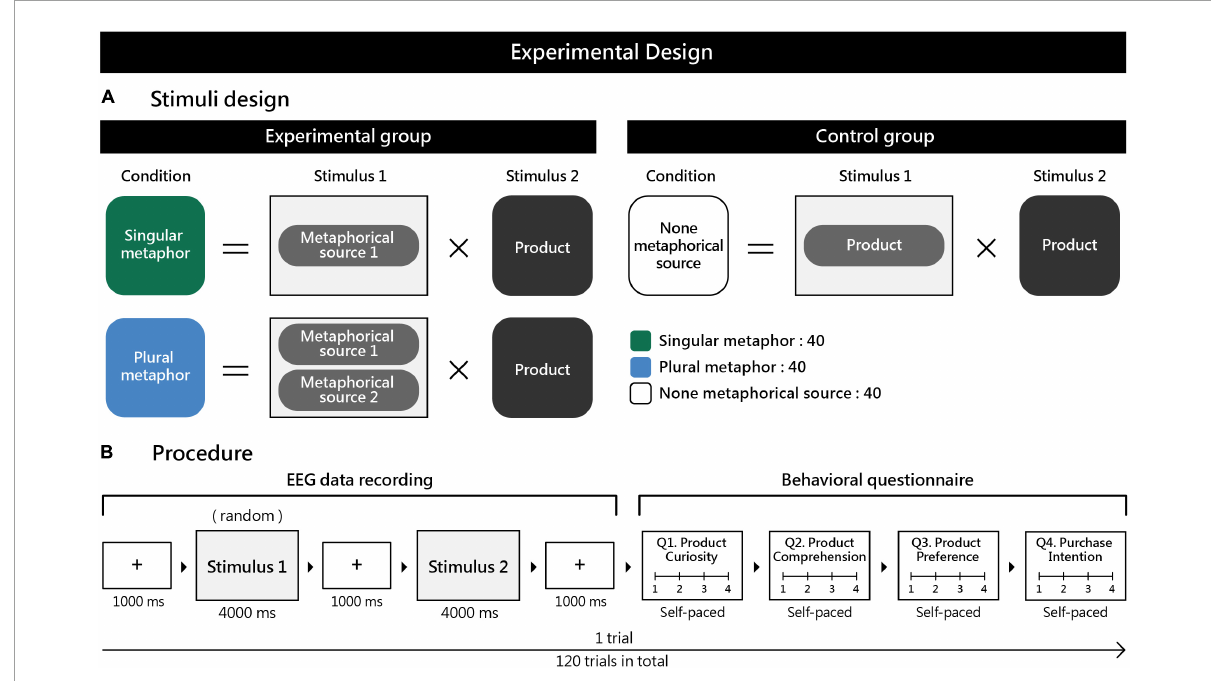
FIGURE1 (A) Each experimental condition consisted of stimuli 1 and 2. The three conditions are described as follows: The singular metaphorical source condition involved presenting a surreal marketing image with one metaphorical source (stimulus 1) + an actual product image (stimulus 2), for a total of 40 trials. The plural metaphorical sources condition involved presenting a surreal marketing image with two metaphorical sources (stimulus 1) + an actual product image (stimulus 2) for a total of 40 trials. The no metaphorical source condition involved presenting actual product images for both stimuli 1 and 2 for a total of 40 trials. (B) One trial in the experimental procedure consisted of EEG data recording and the administration of a behavioral questionnaire. EEG data recording: A fixation cross was first presented for 1000 ms, followed by the randomized presentation of marketing images (stimulus 1) for 4000 ms. The fixation cross was presented again for 1000 ms, and then the product image (stimulus 2) was presented for 4000 ms. At the end of the EEG data recording, the behavioral questionnaire was administered. Participants were required to answer questions on product curiosity, comprehension, preference, and purchase intention using a four-point Likert scale (1 = completely disagree, 2 = disagree, 3 = agree, 4 = completely agree). The questionnaire response time was self-paced. The entire experiment consisted of 120 trials and lasted for 30–40